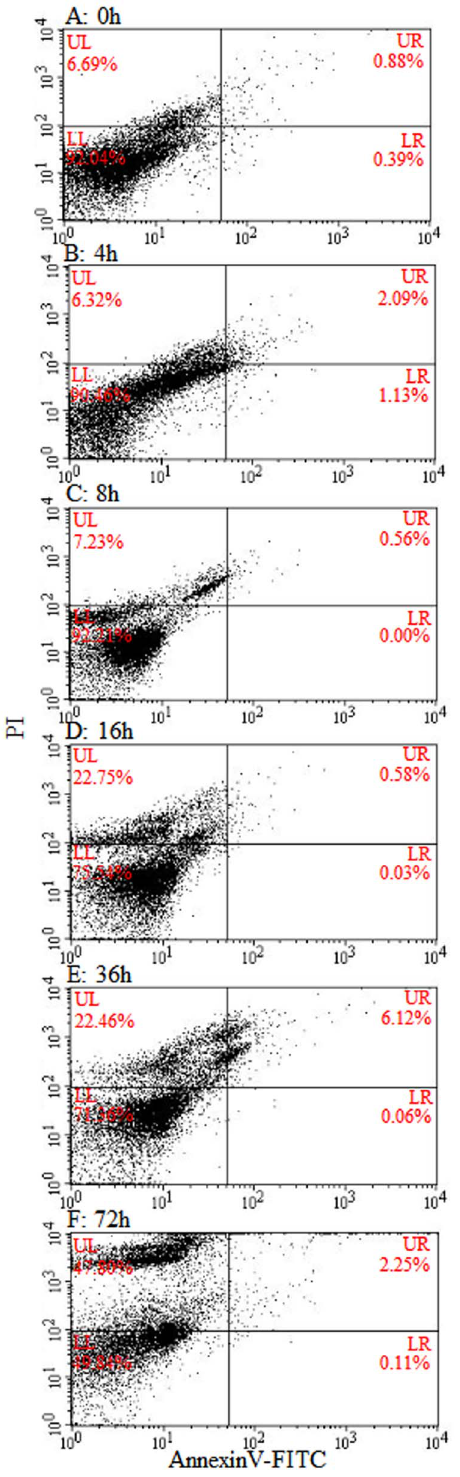
Figure 7. Flow cytometric analysis of hemocytes stained with Fluorescein isothiocyanate (FITC)-annexin/Propidium Iodide (PI). Non-florescent carboxylate-modified polystyrene latex beads were injected into the hemocoel at 0, 4, 8, 12, and 48 h. The percentage of PI negative and annexin-V positive hemocytes (LR quadrant) was 0.39, 1.13, 0.00, 0.03, 0.06, and 0.11% at 0, 4, 8, 16, 36, and 72 h post injection, respectively. However, the percentage of PI-positive and annexin-V negative hemocytes (UL quadrant) increased from 6.69% at 0 h